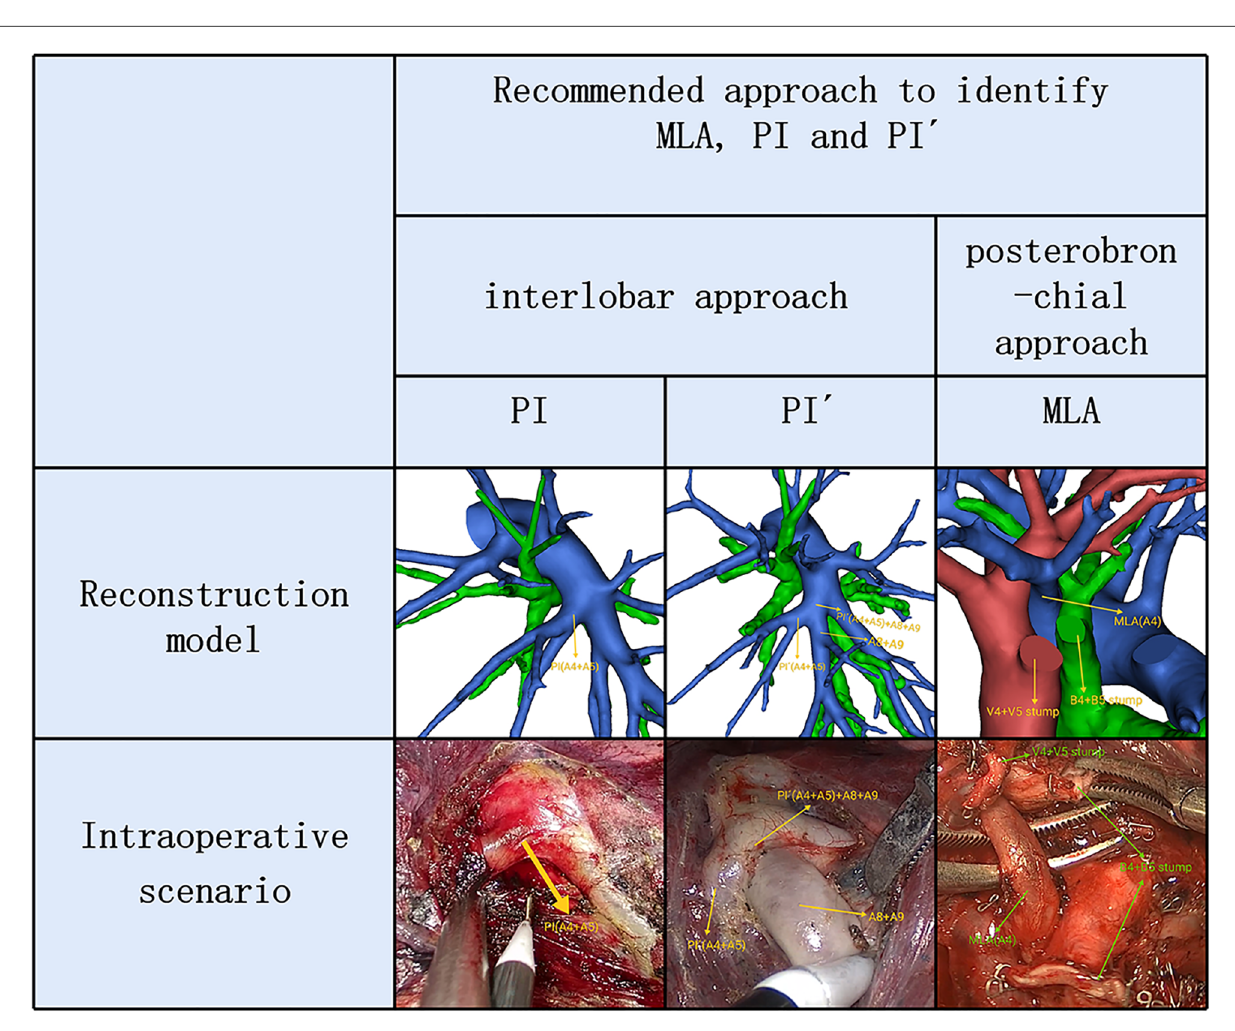
FIGURE 6 3D reconstruction and intraoperative scenario of two basic approaches identifying MLA, PI and